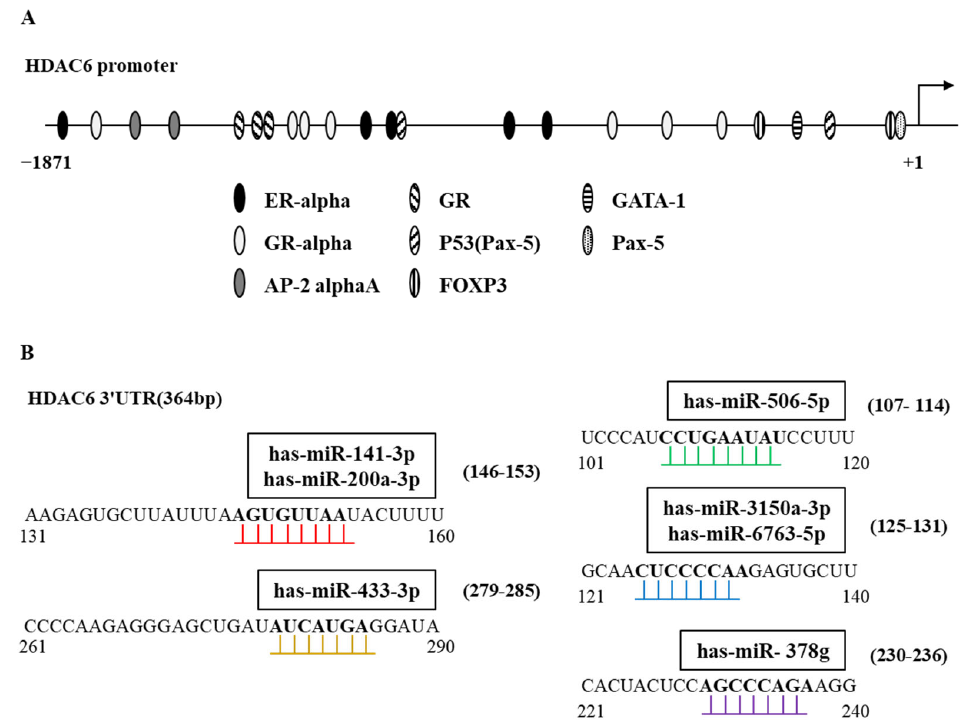
Figure 3. Expression regulation of HDAC6 and roles of HDAC6-targeting miRNAs in cancer cell proliferation. ( A ) Shows potential binding sites for various transcription factors in promoter sequences of HDAC6. ( B ) miRNAs that potentially target HDAC6. The potential binding of the miRNAs to the 3 (cid:48) UTR of HDAC6 is shown. Seed sequences of miRNAs are shown. UTR denotes untranslated region. MicroRNAs (miRNAs) are small non-coding RNAs that can downregulate the expres- sion of genes involved in carcinogenesis [36,37]. The expression of miR-601 is decreased in esophageal squamous cell carcinoma (ESCC) tissues and cells [37]. miR-601 is predicted to regulate the expression of HDAC6 and suppress the proliferation of ESCC cells [37]. miR-22 is down-regulated in cervical cancer and shows inverse correlation with its downstream target HDAC6 [38]. miR-22-overexpressing macrophages inhibited glioma formation by targeting HDAC6 and NF- κ B signaling in tumor-associated macrophages (TAMs) [39]. HDAC6 shows aberrant expression in diffuse large B-cell lymphoma (DLBCL). HDAC6 inhibition exerts anti-tumor effects both in vitro and in vivo [40]. The decreased expres- sion of miR-27b in DLBCL tissues predicts the poor overall survival of patients with DLBCL [40]. Rel A/p65 negatively regulates miR-27b expression. HDAC6 inhibition was shown to increase miR-27b expression by acetylation and block of nuclear translocation of RelA/p65 [40]. miR-27b represses mesenchymal-to-epithelial transition (MET) and MET/PI3K/AKT pathway